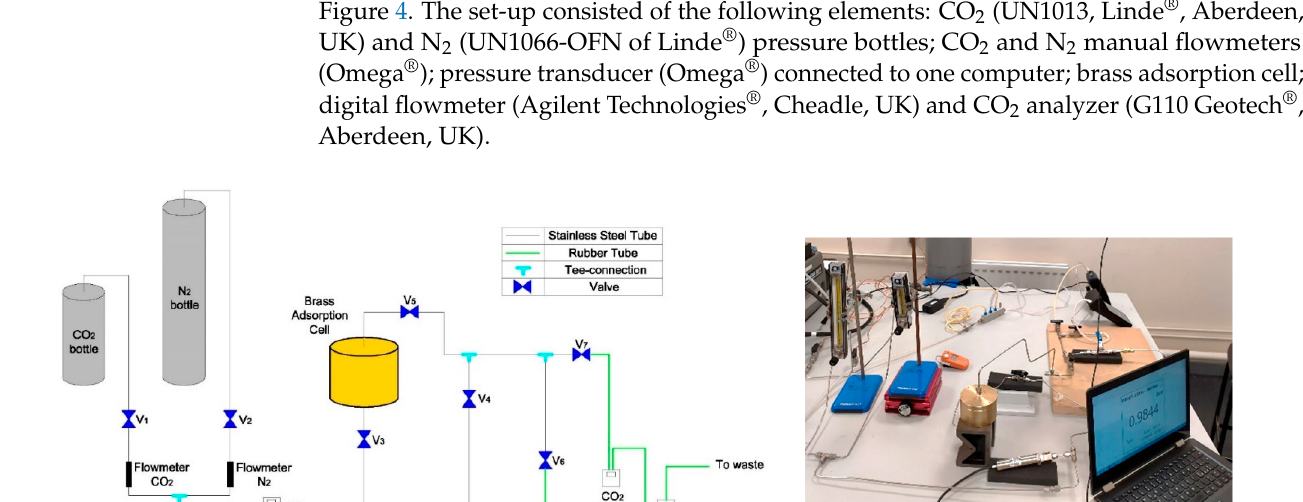
Figure 4. Graphical flow diagram of the experimental system ( a ) and lab adsorption system ( b ) (operating at room temperature).